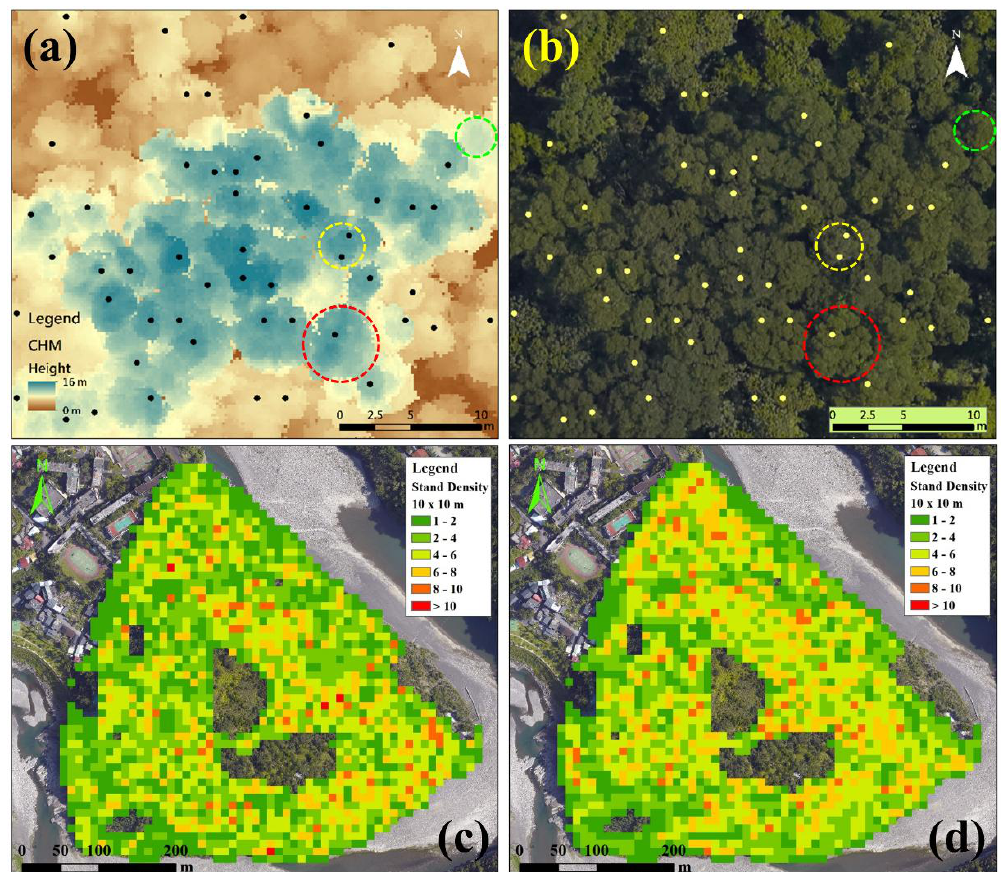
Figure 5. The CHM HFe , treetop positions, and stand density map using LiDAR data. ( a ) the CHM HFe (Csize = 0.2 m) and treetop positions (using the local maximum method and marked by the black dots); ( b ) Aerial photographs and treetop positions (same as a and marked by the yellow dots). The range of a , b is marked in Figure 1a with a red dotted line; ( c ) Stand density map, which was using CHM Fe and parameters that were Csize = 0.5 m and 𝐾𝑠𝑖𝑧𝑒 = 5; ( d ) Stand density map of regression corrected, which was using CHM Le and parameters that were Csize = 0.2 m and 𝐾𝑠𝑖𝑧𝑒 = 3.